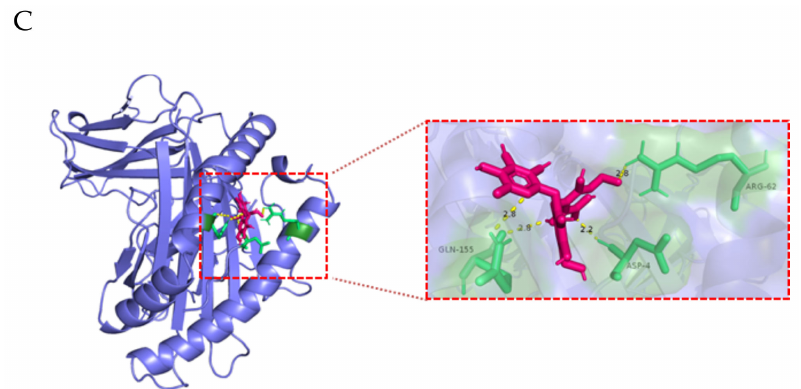
Figure 6. Docking analysis visualisation of 2’-FL binding with ( A ) ITGB6 (PDB: 4UM8), ( B ) FCGRT (PDB: 1EXU), and ( C ) β 2 M (PDB: 1A1M). The yellow dots show H-bonds. The ITGB6-2’-FL complex structure highlighting the ITGB6 (blue), 2’-FL (magenta) and residue I216 (green); the FCGRT-2’-FL complex structure highlighting the FCGRT (blue), 2’-FL (magenta) and residue W51 (green); The β β 2 M-2’-FL complex structure highlighting the 2 M (blue), 2’-FL (magenta) and residue Q155, D4 and R62